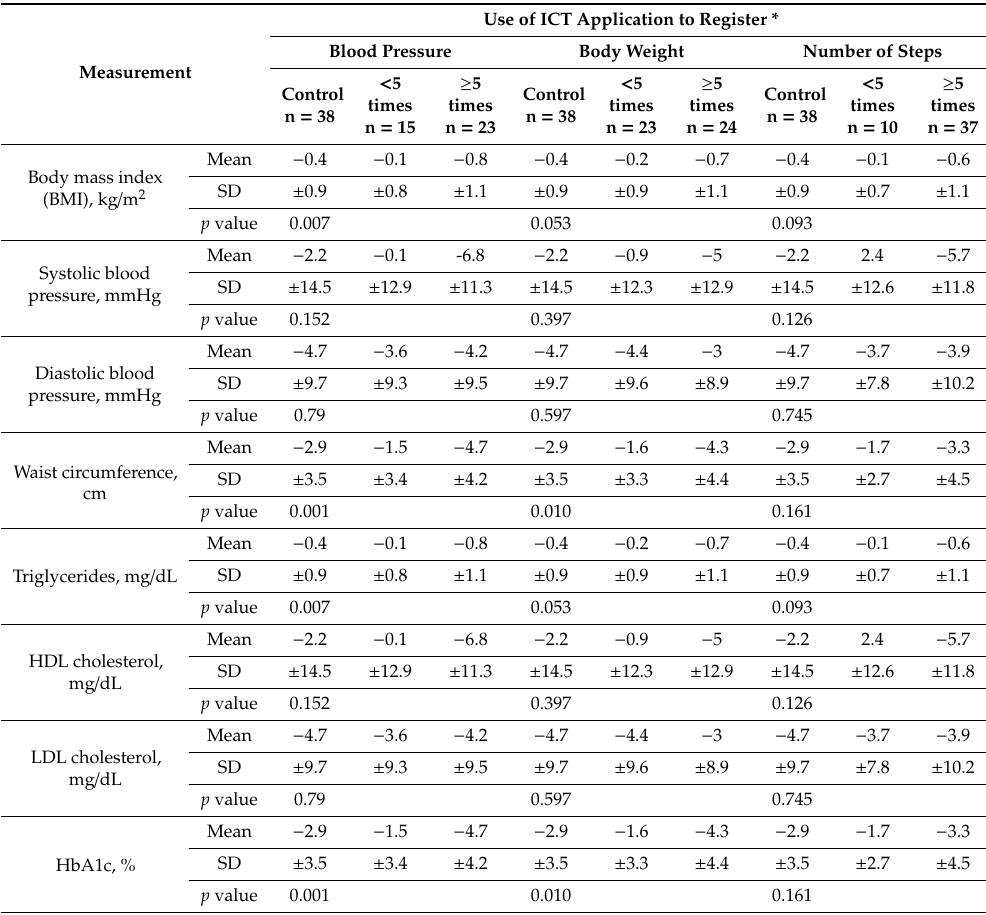
Table 3. Comparison of change for ICT participants by frequency of app use.